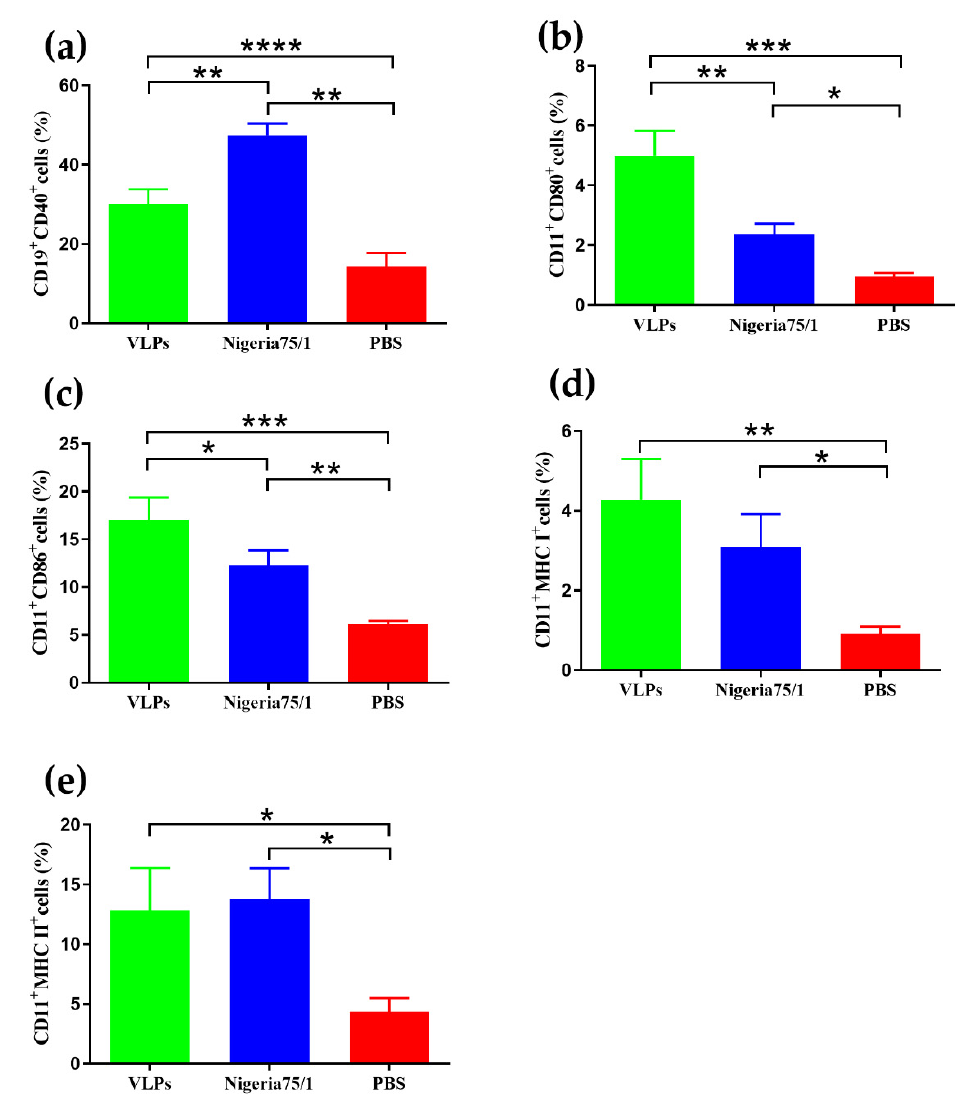
Figure 5. Immunization induces enhanced B cell and dendritic cell recruitment and activation. Two weeks after the second immunization, five mice from each group were euthanized for collection of cells from the inguinal lymph nodes. Mouse monoclonal antibodies against CD19, CD40, CD80, CD86, MCH I, and MCH II were used to identify cells that were double-positive ( a ) CD19 + CD40 + , ( b ) CD11c + CD86 + , ( c ) CD11c + CD80 + , ( d ) CD11c + MHC I + , and ( e ) CD11c + MHC II + . Significant di ff erences were analyzed by one-way ANOVA and indicated as follows: * P < 0.05, ** P < 0.01, *** P < 0.001, **** P < 0.0001.